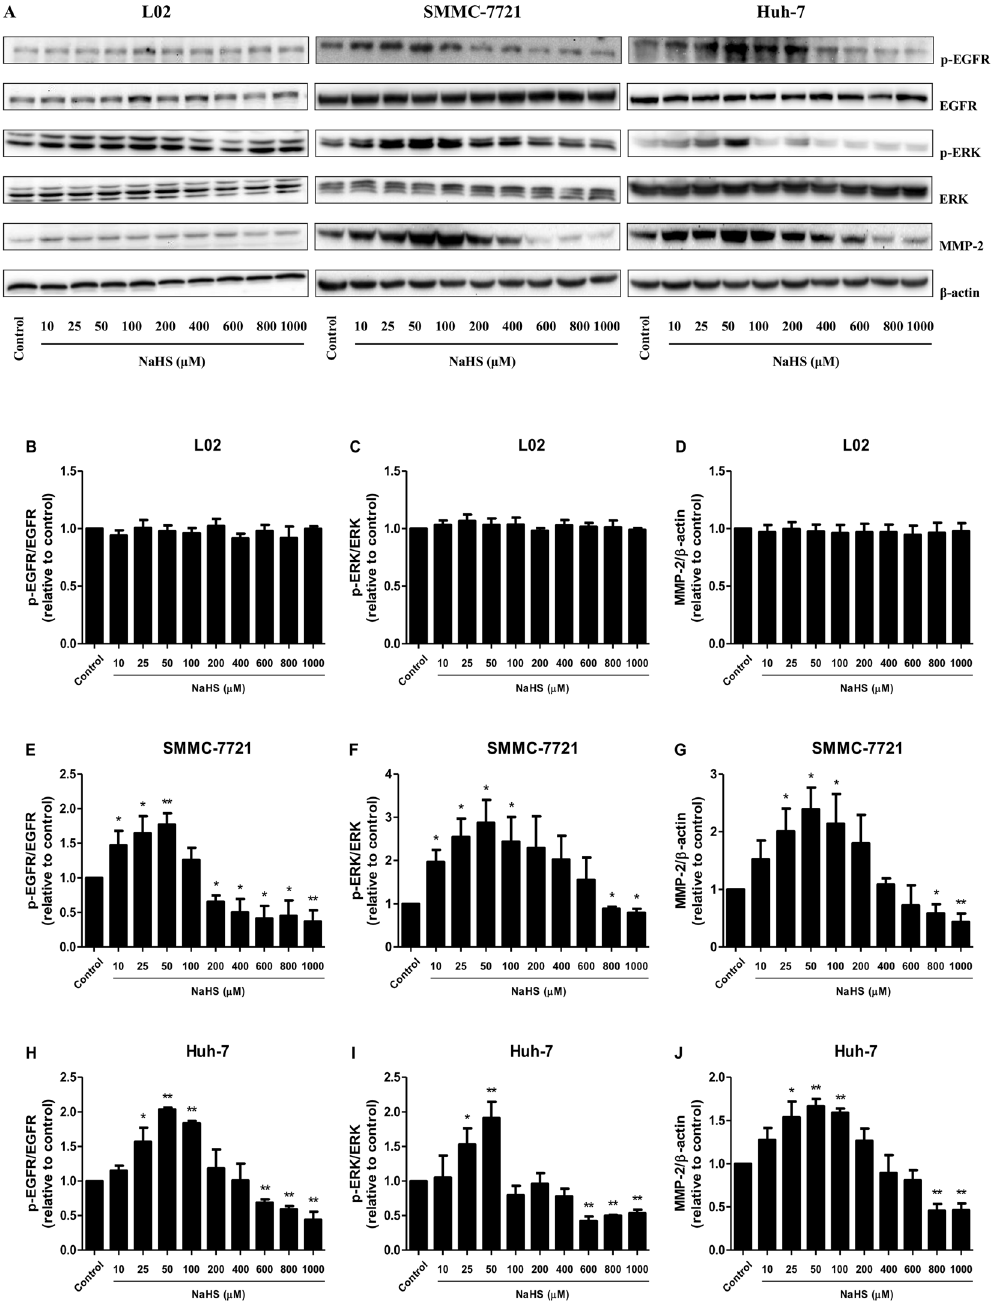
Figure 5. H 2 S mediated the EGFR/ERK/MMP-2 pathway in human HCC cells. L02, SMMC-7721, and Huh-7 cells were cultured in 6-well plates and treated with NaHS at concentrations of 0 (Control), 10, 25, 50, 100, 200, 400, 600, 800, and 1000 μ M for 24 h, then the protein expression levels of the indicated factors were examined by Western blot. β -actin was used as the loading control. The densitometry analysis of each factor was performed, normalized to the corresponding β -actin level. Values were presented as mean ± SEM of three independent experiments; * P < 0.05, ** P < 0.01 compared with the control